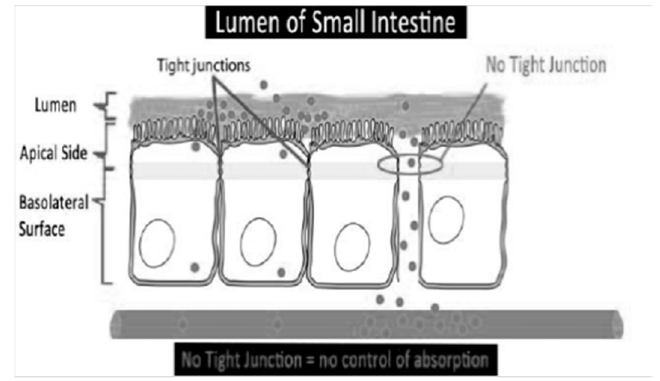
Figure 3. Tight junctions (De Mauri, AOU della Carità, Novara, Italy).